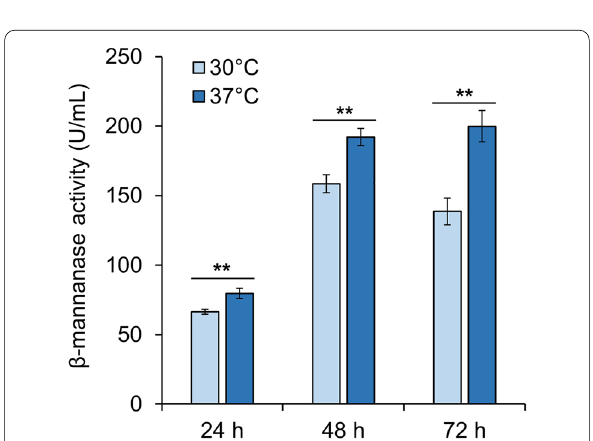
Fig. 5 β-Mannanase production by the strain containing multiple PcMC- poman5A cassettes. Data represent mean cultivations. The statistical significances of the difference between cultures at 30 °C and 37 °C are shown. *, P < 0.05; **, P < 0.01; ***, P <